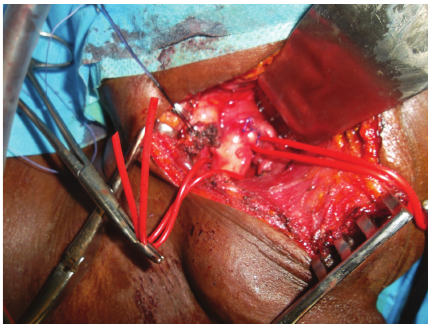
Figure 6: Operative view of the external carotid artery connected to